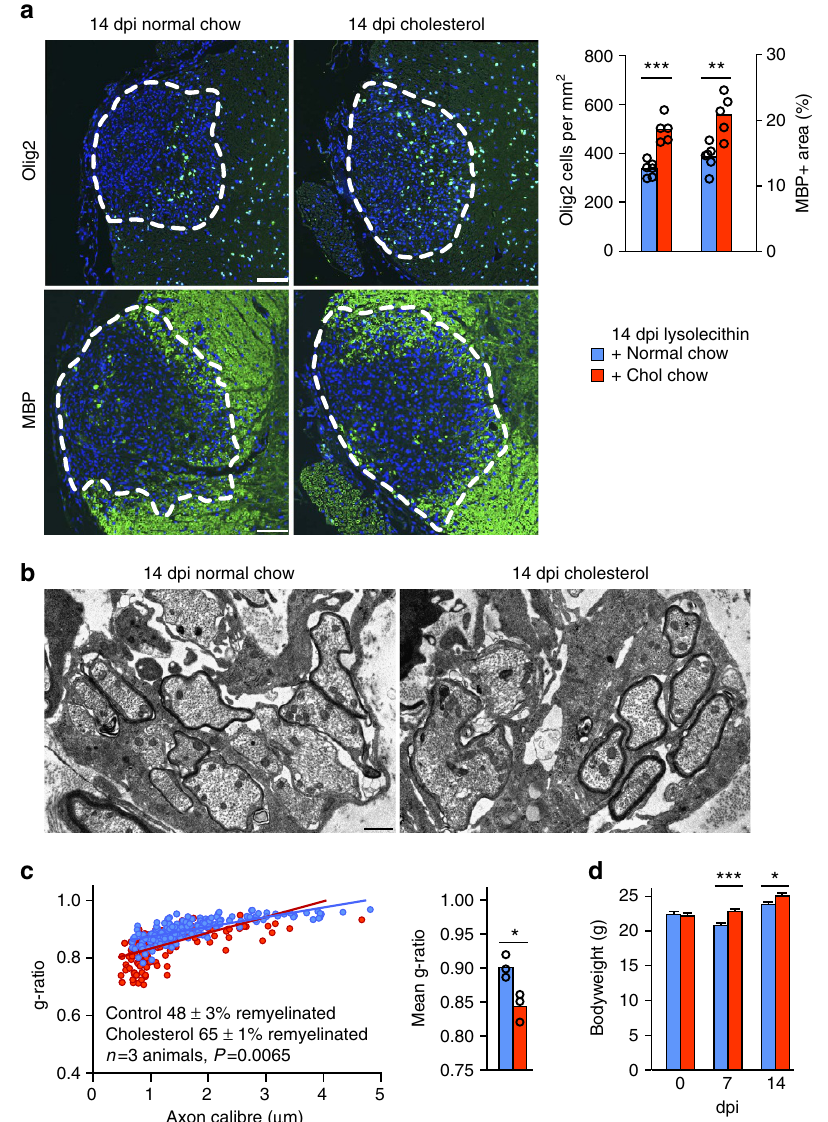
Figure 6 | Cholesterol supports remyelination in the lysolecithin model. ( a ) Representative images of spinal cord sections 14 days post lesion (dpl) with 1 m l 1% lysolecithin in the ventral spinal cord with quantification of n ¼ 5 (cholesterol chow) and n ¼ 6 (normal chow) animals. Student’s t -tests revealed significantly more Olig2 positive oligodendroglial cells within the lesion area ( P o 0.0001), and significantly more MBP positive area ( P ¼ 0.027; scales, 100 m m). ( b , c ) Representative electron micrographs (scale 1 m m) and quantification of myelin sheath thickness and the portion of remyelinated axons